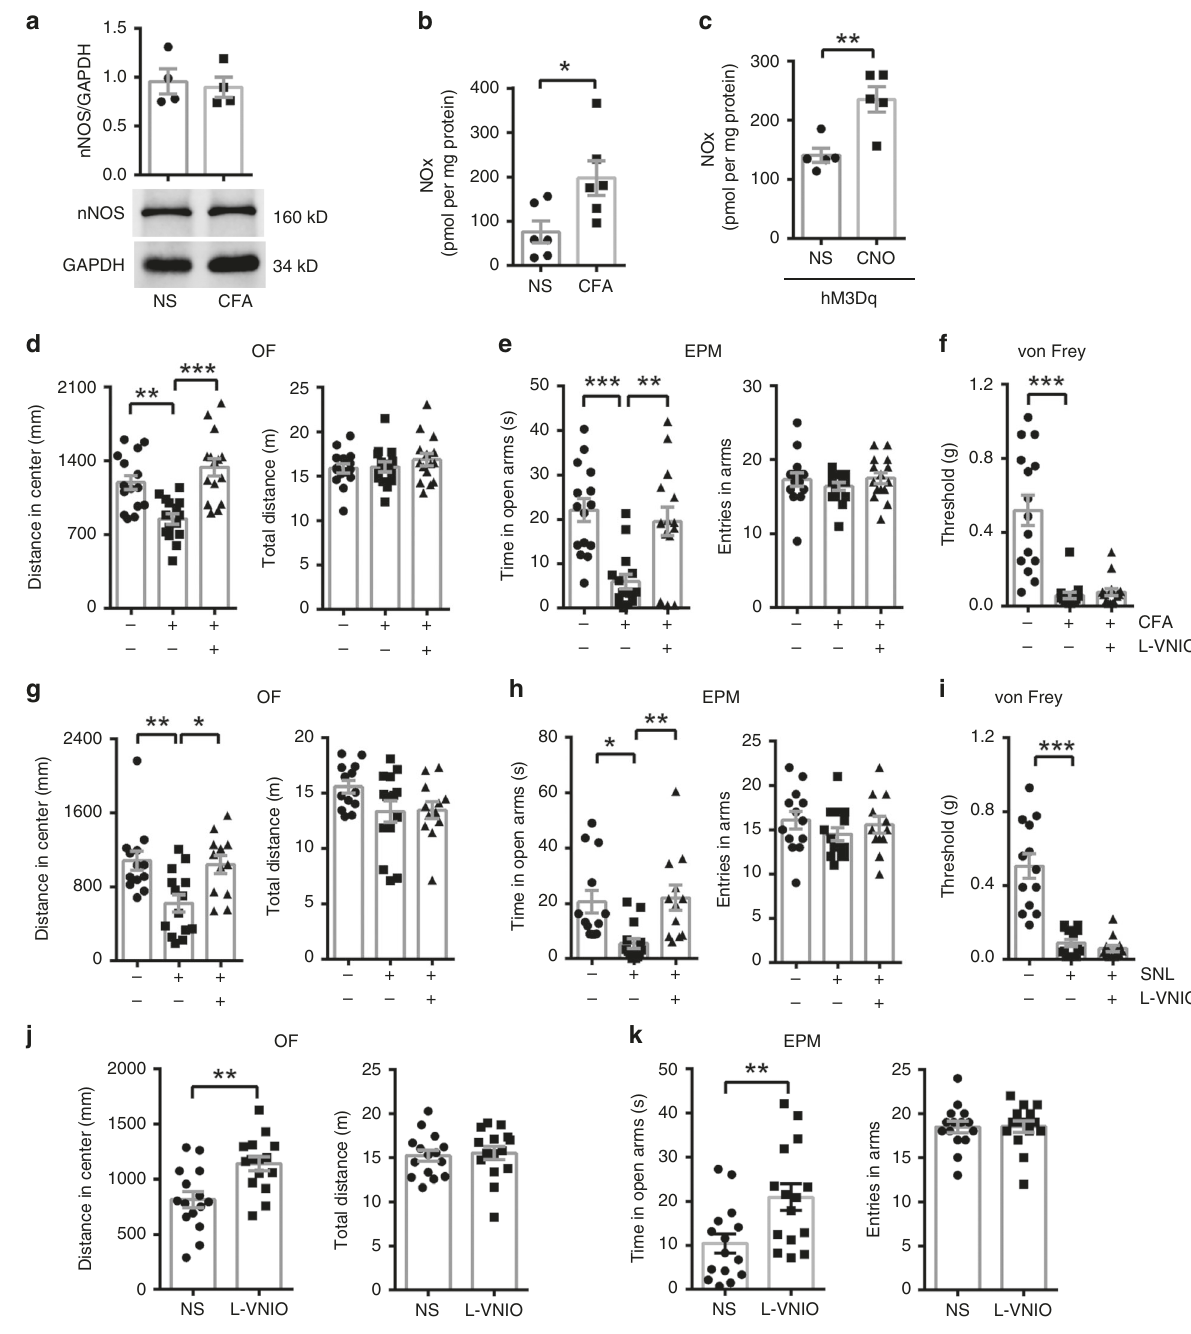
Fig. 8 nNOS-expressing neurons in the vmPFC mediate chronic pain-induced anxiety through diffusing NO. a , b Dot plot ( a , upper) and western bolts ( a , lower) showing nNOS protein levels ( n = 4), and dot plot ( b ) showing nNOS enzyme activity in the vmPFC at day 3 after CFA or NS injection ( n = 6). c Dot plot showing nNOS enzyme activity of the vmPFC 30 min after CNO (0.5 mM, 1 μ l) or NS delivery at day 21 after AAV-hSyn-DIO-hM3Dq-eGFP microinjection (0.4 μ l) in the vmPFC of nNOS-Cre mice ( n = 5). d – f Distance in center ( d , left) and total distance ( d , right) in an OF test, time in open arms ( e , left) and total entries in arms ( e , right) of an EPM test, and withdrawal threshold of hind paw in an von Frey test ( f ) 30 min after L-VNIO (1.5 mM, 1 μ l) or NS (1 μ l) microinjection into vmPFC at day 3 after CFA or NS injection. n = 15. g – i Distance in center ( g , left) and total distance ( g , right) with an OF test, time in open arms ( h , left) and total entries in arms ( h , right) of an EPM test, and withdrawal threshold of the hind paw in an von Frey test ( i ) 30 min after L-VNIO (1.5 mM, 1 μ l) or NS (1 μ l) microinjection in vmPFC at day 7 after SNL or sham operation. n = 13, 14, and 12, respectively. j , k Distance in center ( j , left) and total distance ( j , right) with an OF test, and time in open arms ( k , left) and total entries in arms ( k , right) of an EPM test 30 min after